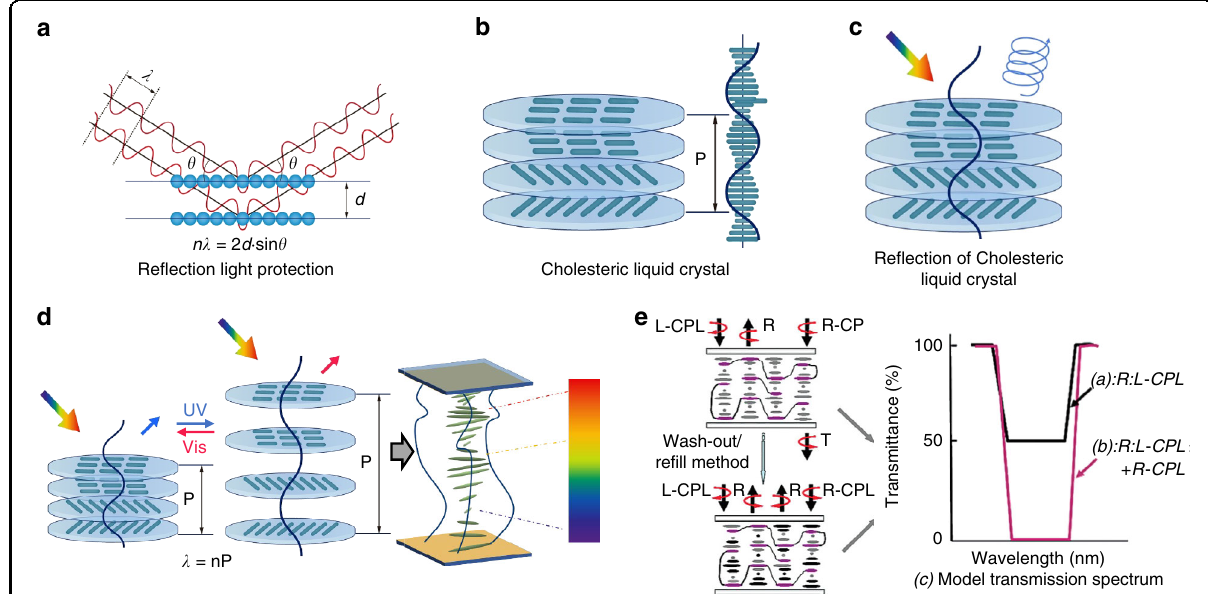
Fig. 8 Photoenergy transfer by the re fl ected path of Ch-LCs. a Bragg re fl ection principle. b Helical superstructure of CLC molecules. c Selective re fl ection of Ch-LCs. d Construction of helical gradients with polymer networks to broaden the re fl ection bands. e Schematic of the method of breaking the re fl ection limit. Reproduced with permission from ref. 127 . Copyright 2009, American Chemical